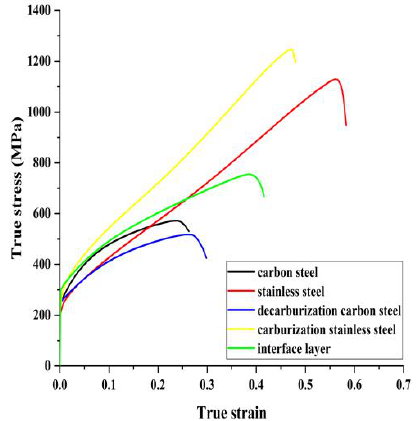
Figure 6. Stress–strain responses of different microstructures of stainless steel clad plate. Table 2. Tensile properties of different microstructures of stainless steel clad plate.